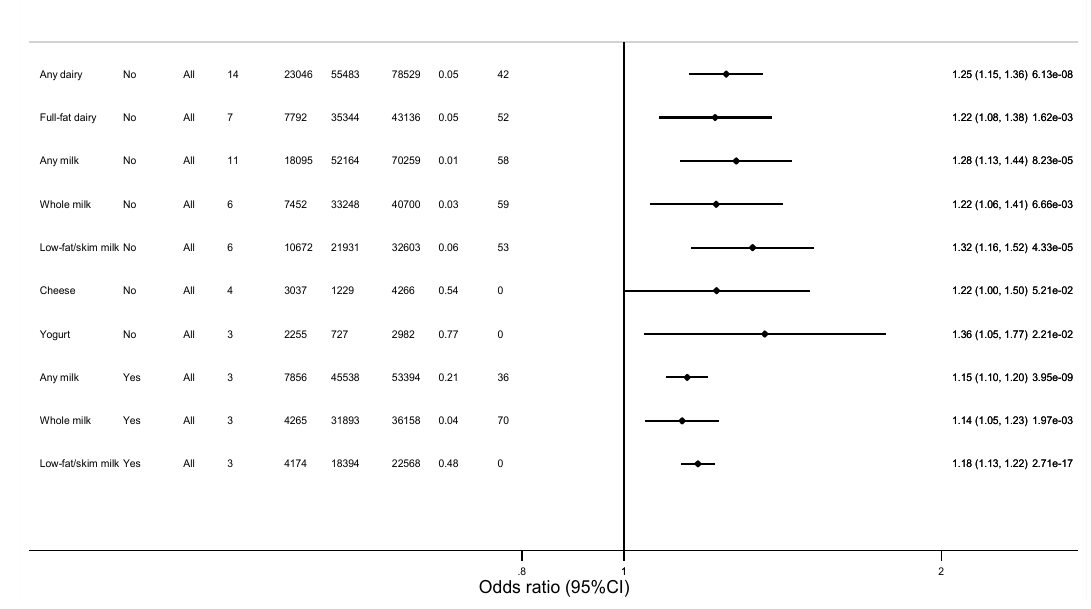
Figure 3. Meta-analyses of dairy intake and acne vulgaris: summary estimates. The figure shows the unadjusted pooled random effects estimates from each of the meta-analyses, which can be found in the supplementary material. I 2 (%): I -square heterogeneity expressed as percentage. p -value(het): p -value from Cochran’s Q -statistic assessing heterogeneity.